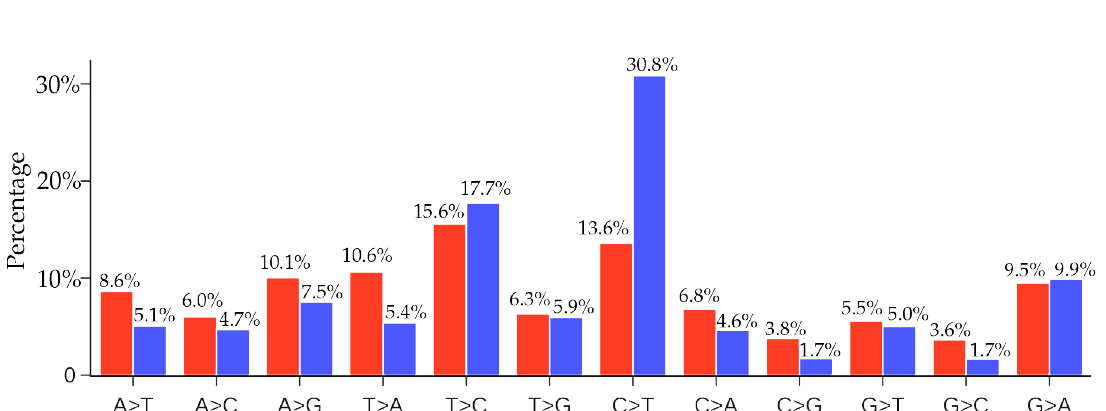
Figure 12. Comparison of the ratios of 12 SNP types among unique mutations (red) and non-unique mutations (blue) in MERS-CoV genome isolates. Here, if we count the same mutation that appears in different MERS-CoV isolates only once, we call those mutations unique mutations. If we count the same mutation in different MERS-CoV isolates repeatedly according to their frequency, then all of the mutations that are detected in the complete MERS-CoV genome sequences are called the non-unique mutations.